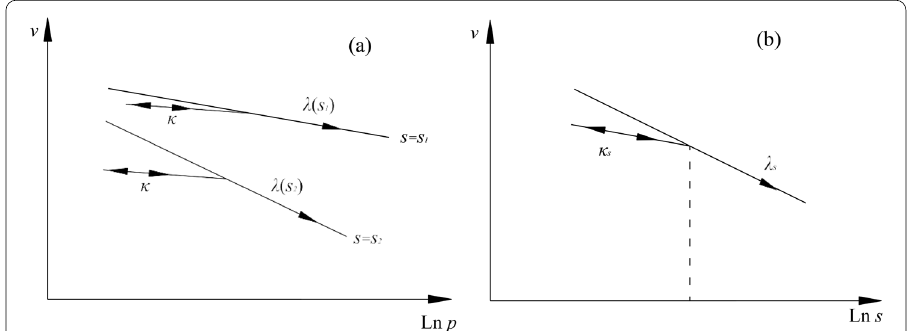
Fig. 2 Compression curves: a In the p-υ plane; b In the s-υ plane